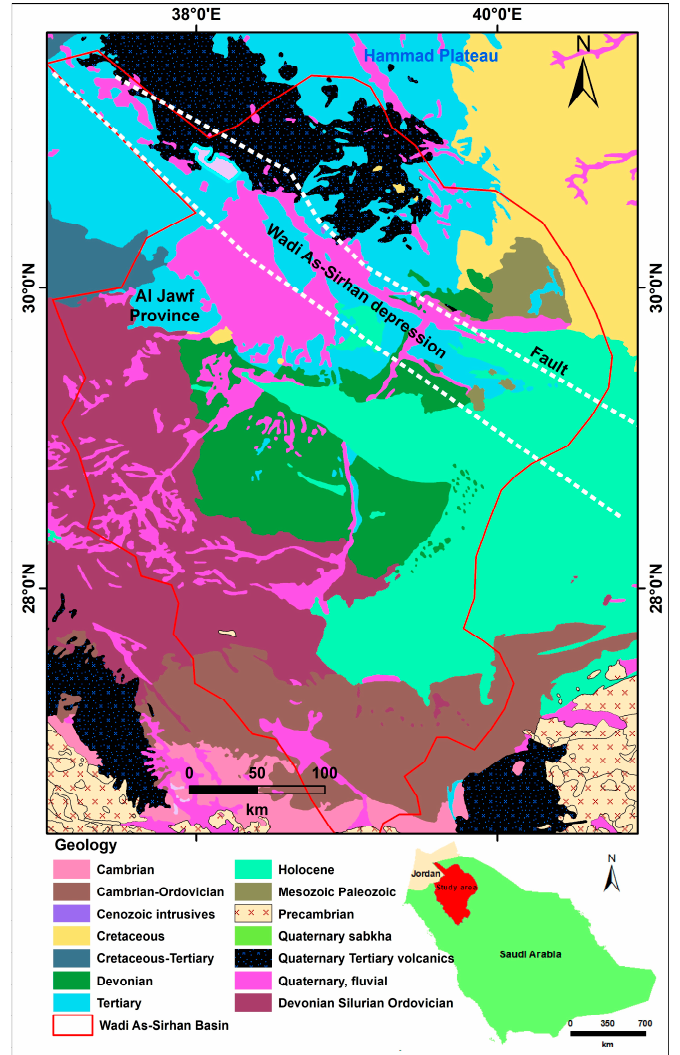
Figure 1. Showing the study area’s